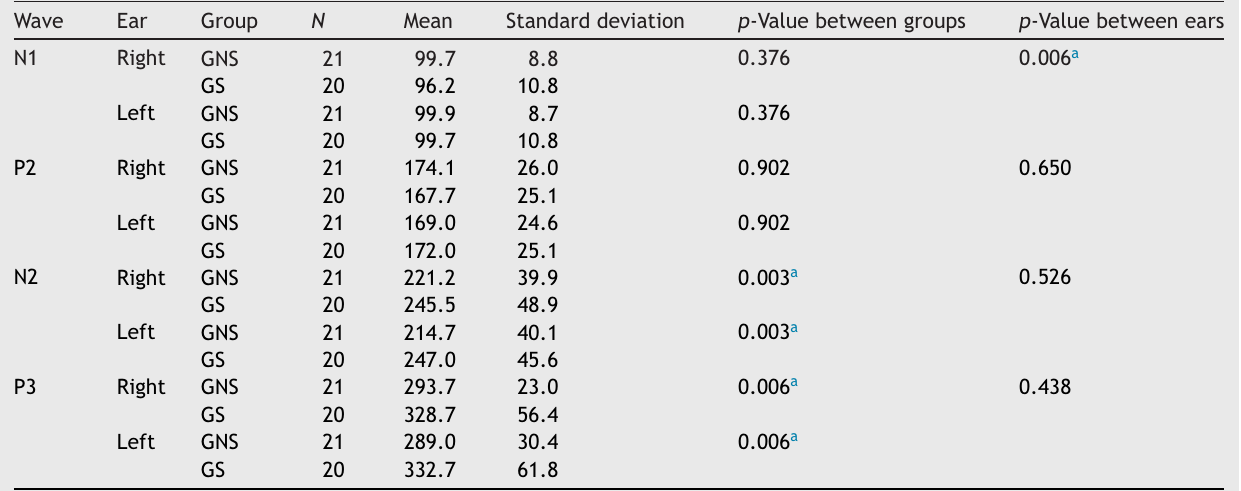
Descriptive measures of the N1, P2, N2, and P3 latencies (ms) in the GNS and GS groups per ear.